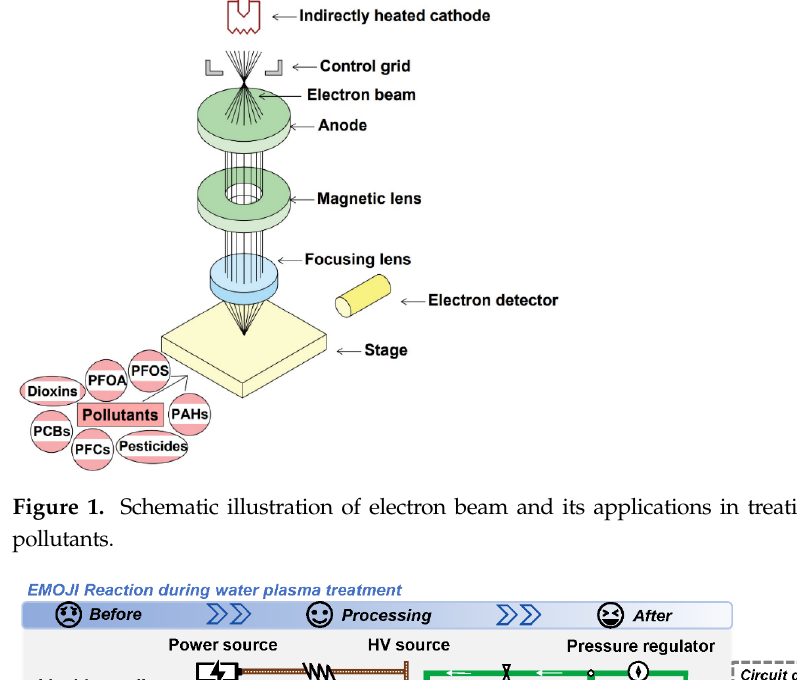
Figure 1. Schematic illustration of electron beam and its applications in treating different organic pollutants.